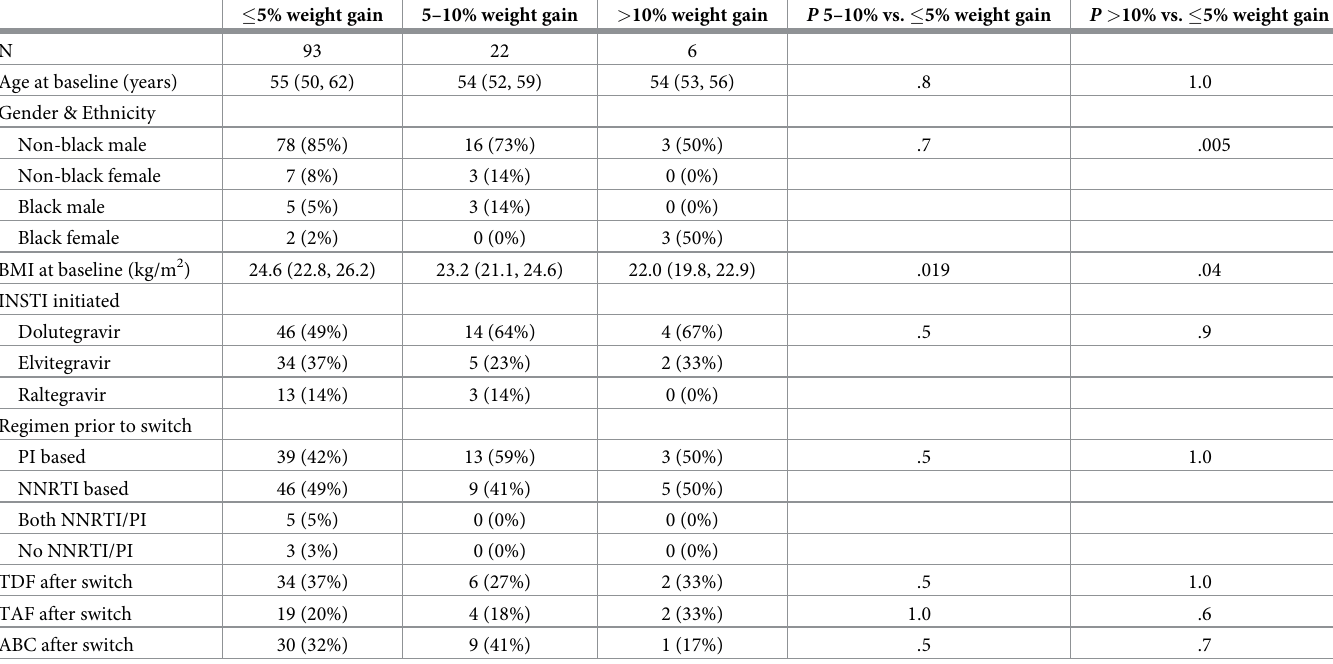
Table 3. Characteristics of INSTI-switching participants with � 5%, 5–10% and > 10% weight gain after INSTI